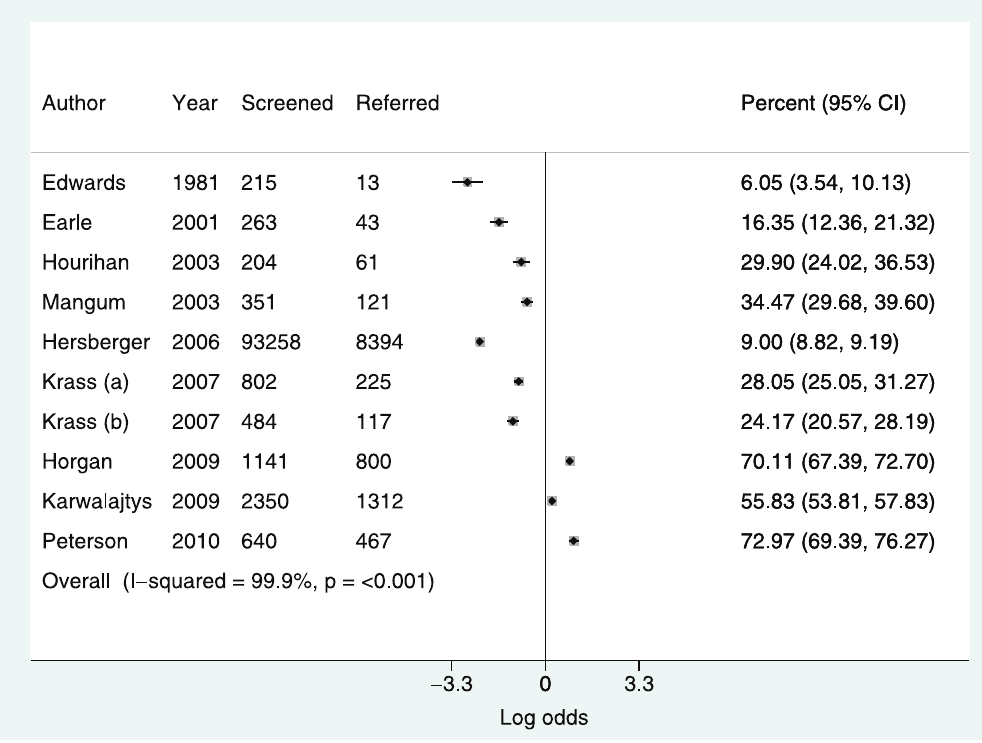
Figure 2. Percentage of screening population referred to their practitioner.